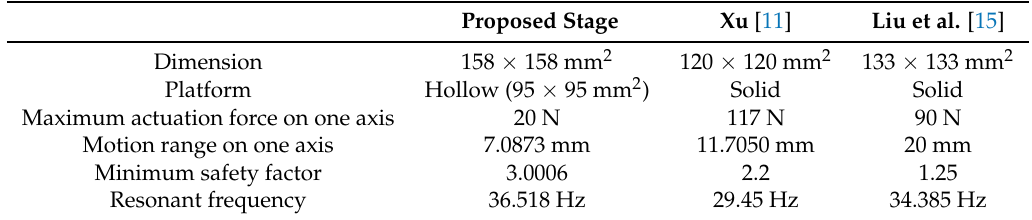
Table 3. Performance comparison versus the previous xy stages with voice coil motor (VCM)